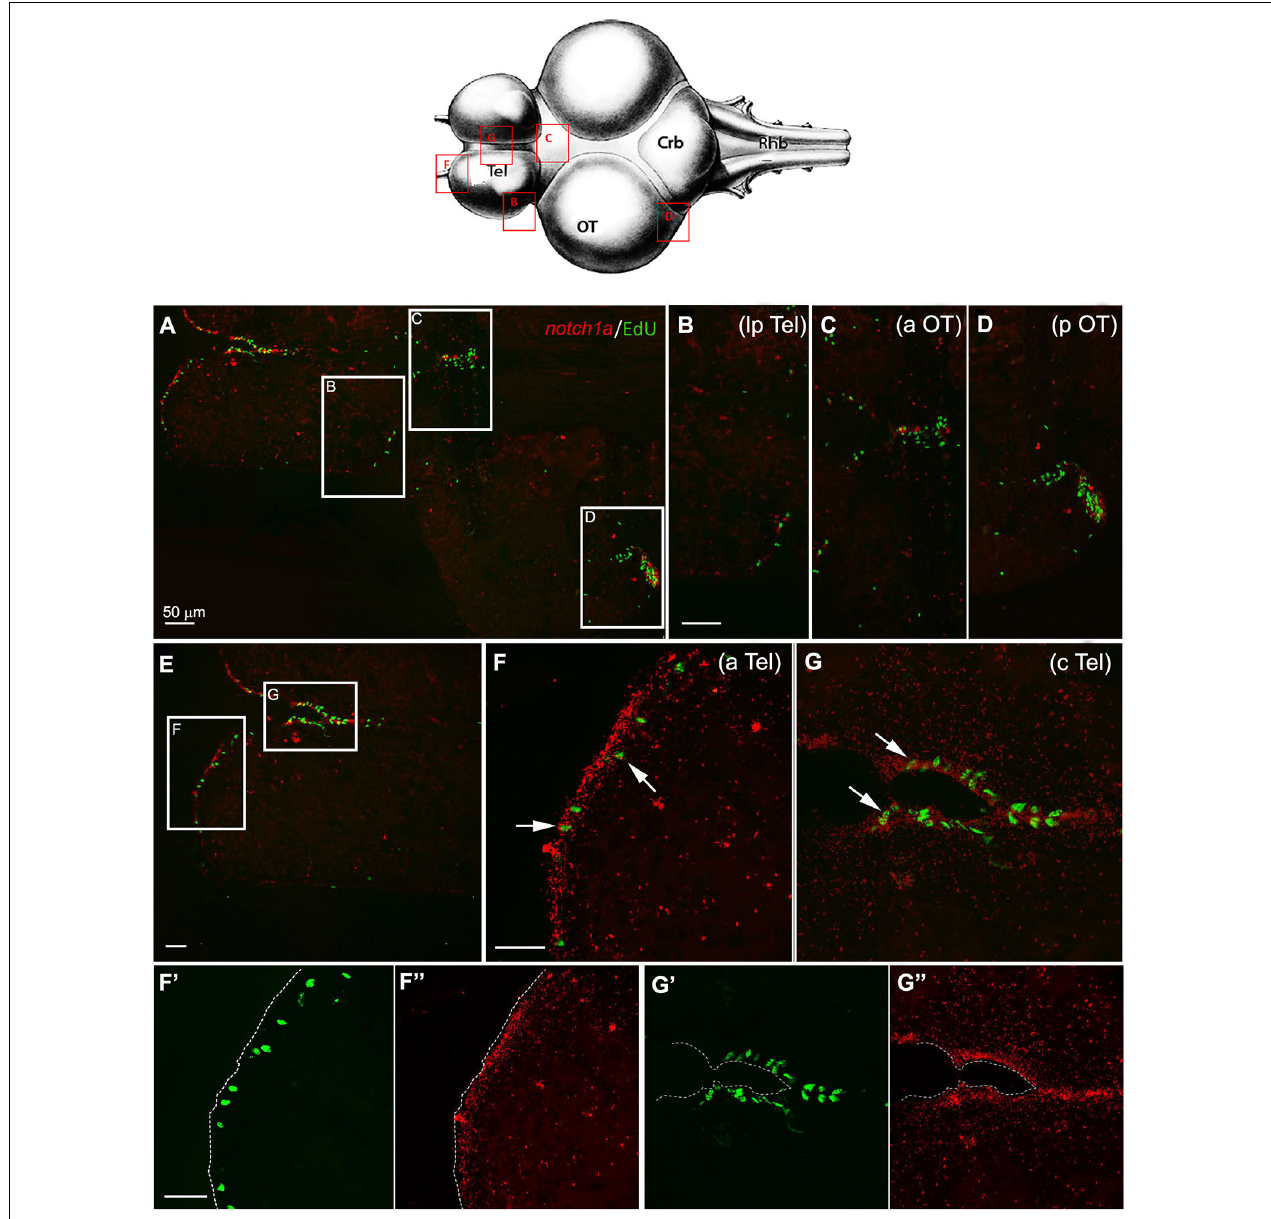
FIGURE 4 | Notch1a expression in proliferative niches of 7-weeks-old N. furzeri brain. (A) Overview of the brain in horizontal medial section (along the dorso/ventral axis) double-stained for ethynyl deoxyuridine (EdU) in green (labeling S-phase cells) and notch1a in red [by in situ hybridization (ISH)]. White frames show the areas magnified in panels (B–D), representing, respectively, the lateroposterior telencephalon (lpTel), the anterior (aOT) and posterior optic tectum (E) representation of the telencephalic structure, labeled for EdU and notch1 . White frames show the areas magnified in panels (F,G), representing, respectively, the anterior (aTel) and central (cTel) telencephalic regions. In panels (F ’ ,F ” ) and (G ’ ,G ” ) green and red separated channels are shown for the two regions in panels (F) and (G) . Scale bars always represent 50 µ m and are indicative for all further images without specific scale bar indication. The upper brain drawing (modified from D’angelo, 2013–Atlas) represents the horizontal overview of the whole killifish brain; red-squared areas indicate the position of the figure panels based on the corresponding letters. White arrows show the presence of double-stained Edu + / notch1a cells.